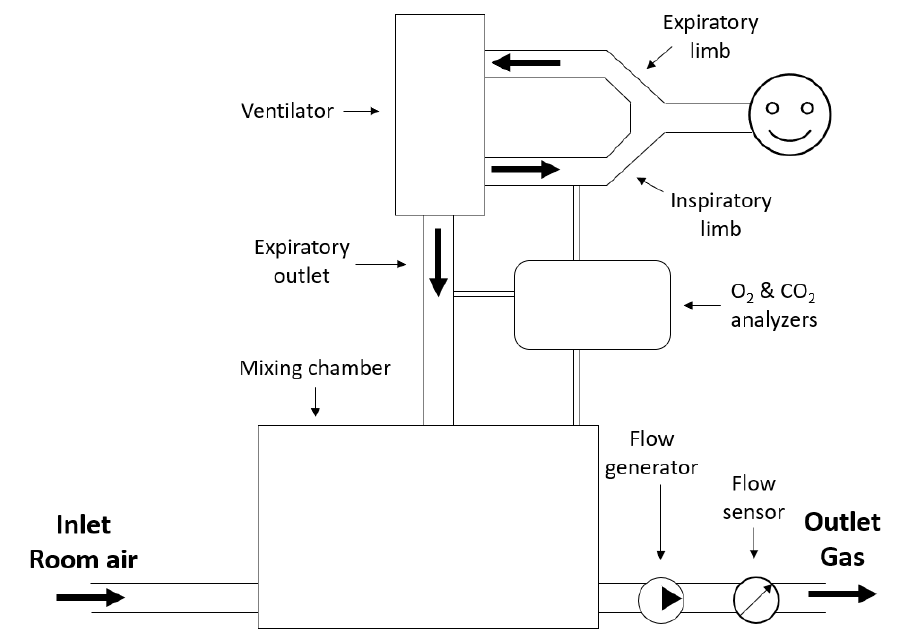
Figure 4. Schematic representation of the open-circuit technique for calculating REE in mechanically ventilated patients with the bold arrows indicating the direction of gas